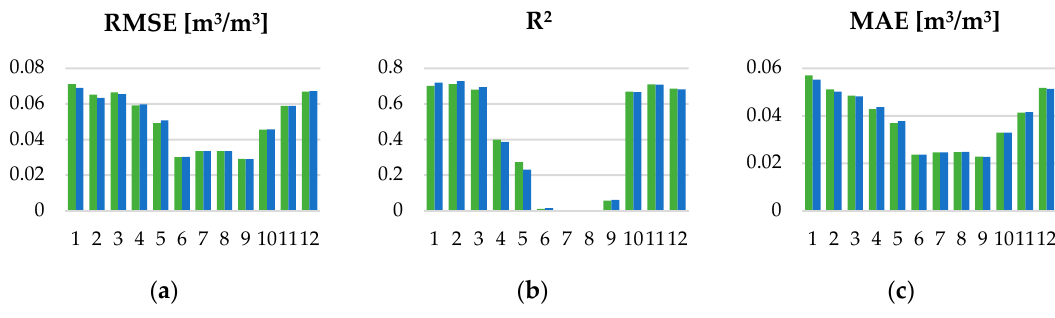
Figure 14. Validation metrics calculated over each month of 2016: (a) RMSE; (b) R 2 ; and (c) MAE;. The monthly metrics correspond to the observed monthly variations. The months with smaller variations in SSM content in June–September period have relatively large measurement uncertainty.